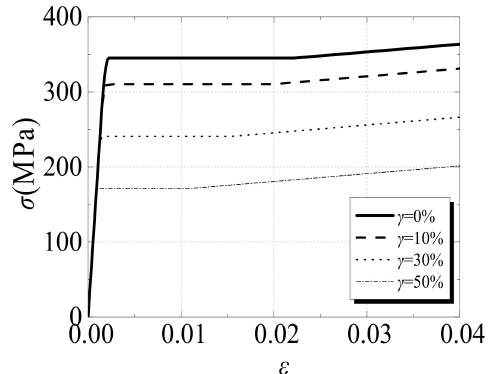
Figure 1. The stress–strain relationship of a steel tube after acid rain